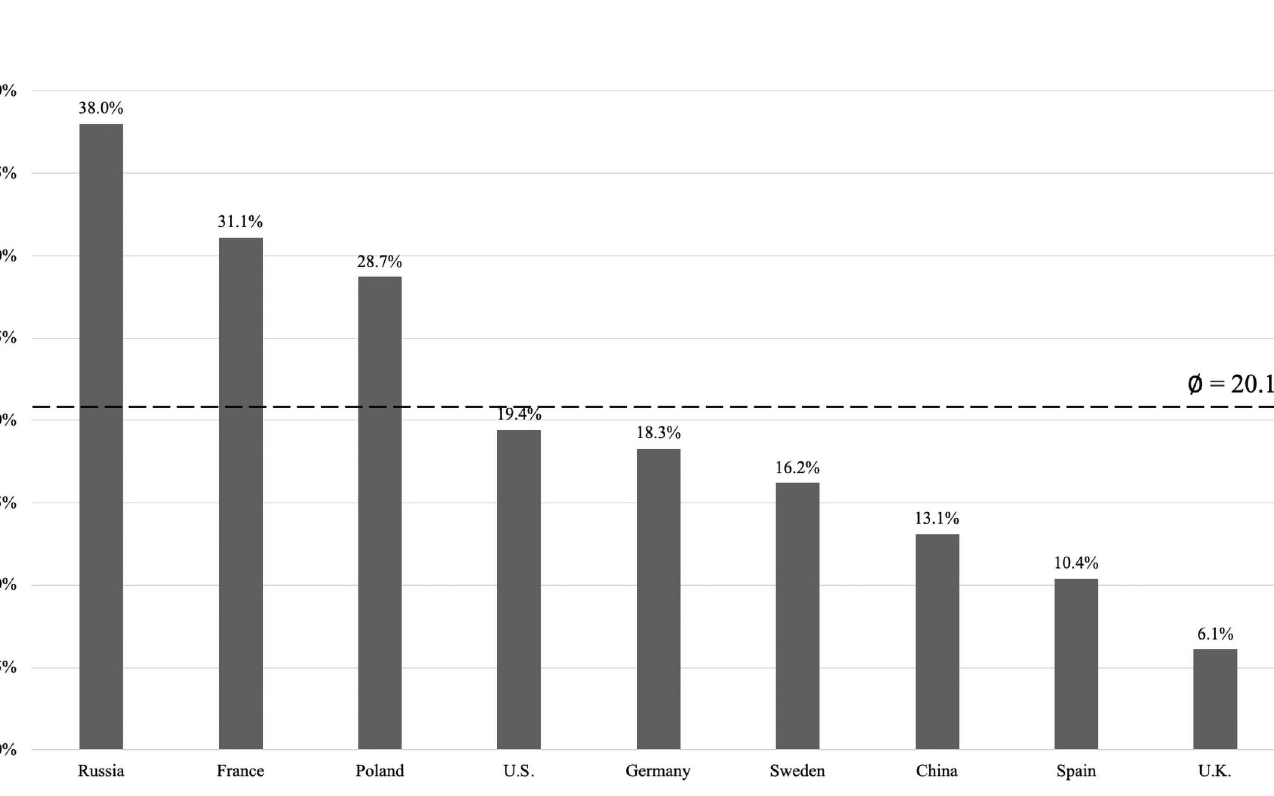
PLOS ONE | https://doi.org/10.1371/journal.pone.0260230 December1, 2021 8 /